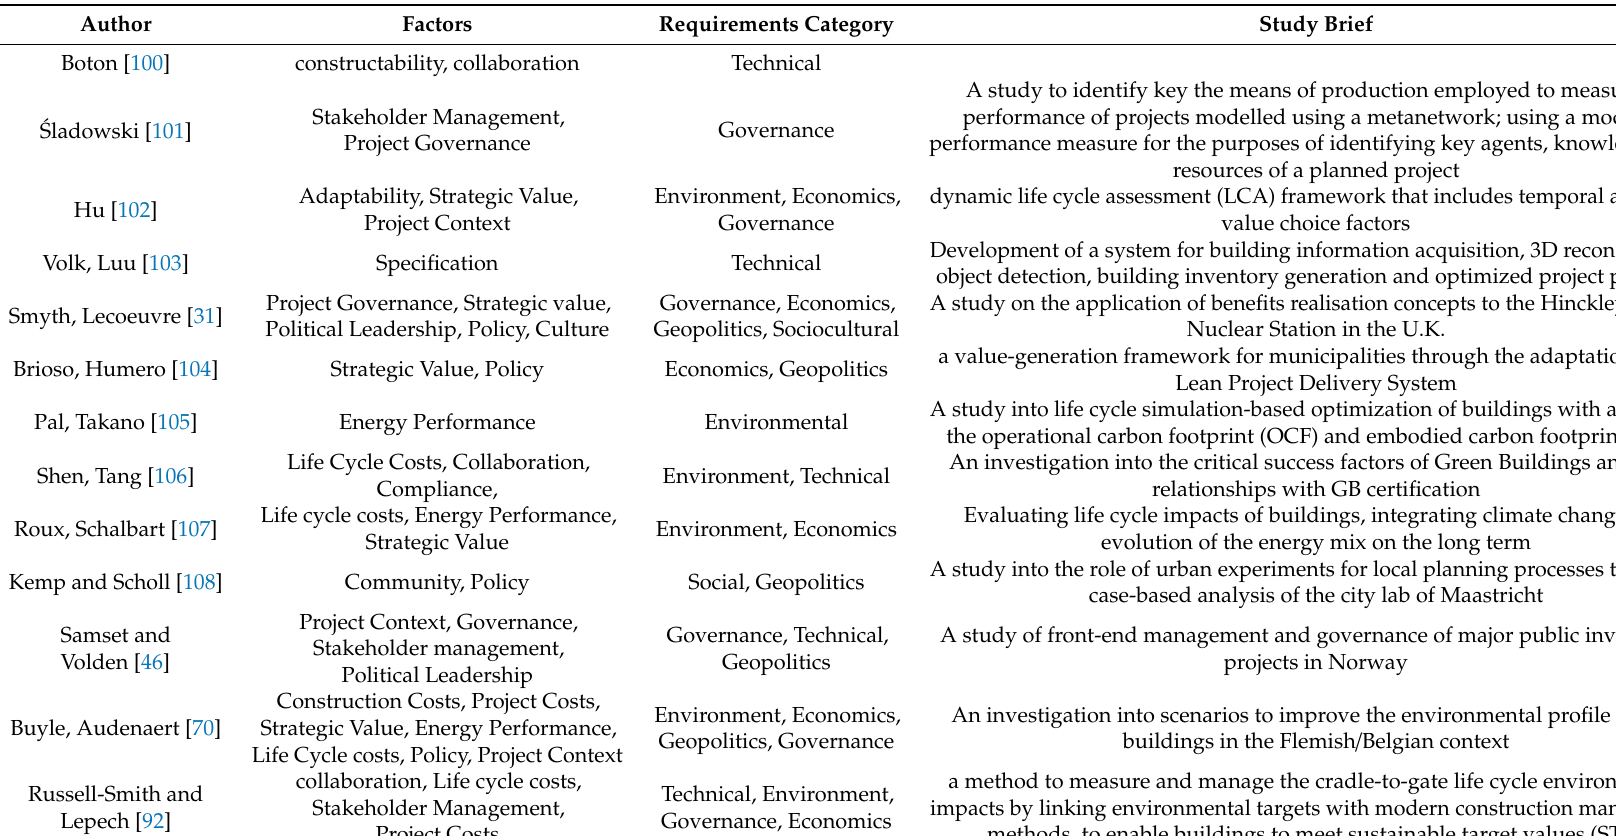
Table A1. Selection of Case Studies in